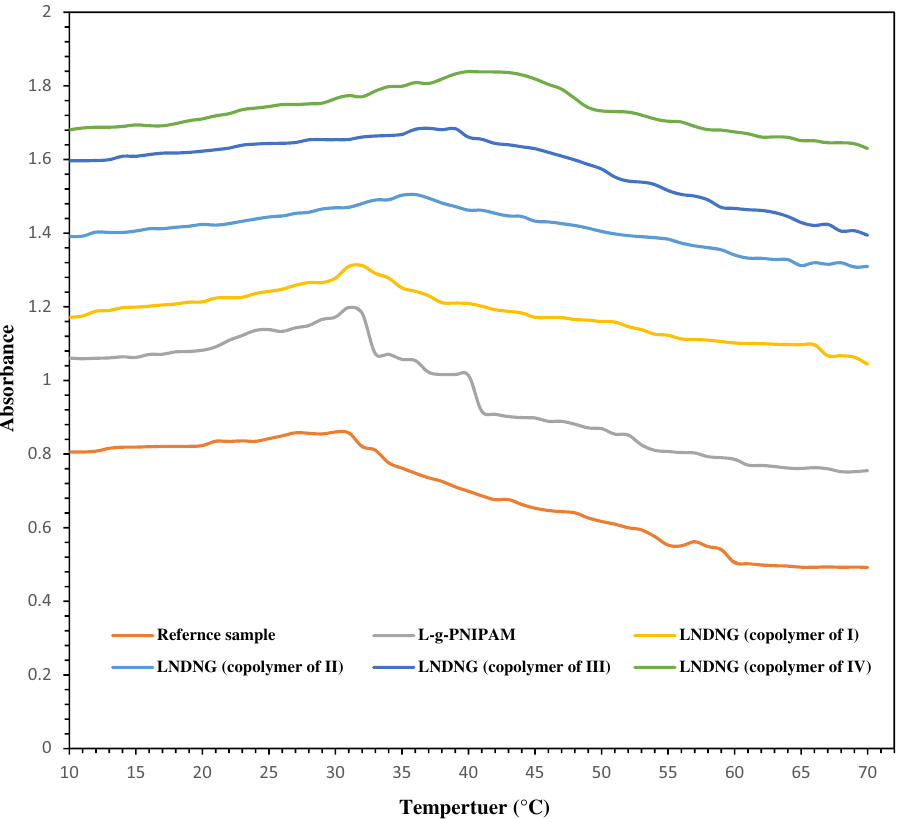
Figure 3. LCST determination of nanogel systems using UV–Visible spectroscopy via recording absorbance versus temperature of nanogel samples by heating rate of 1 °C/min at 500